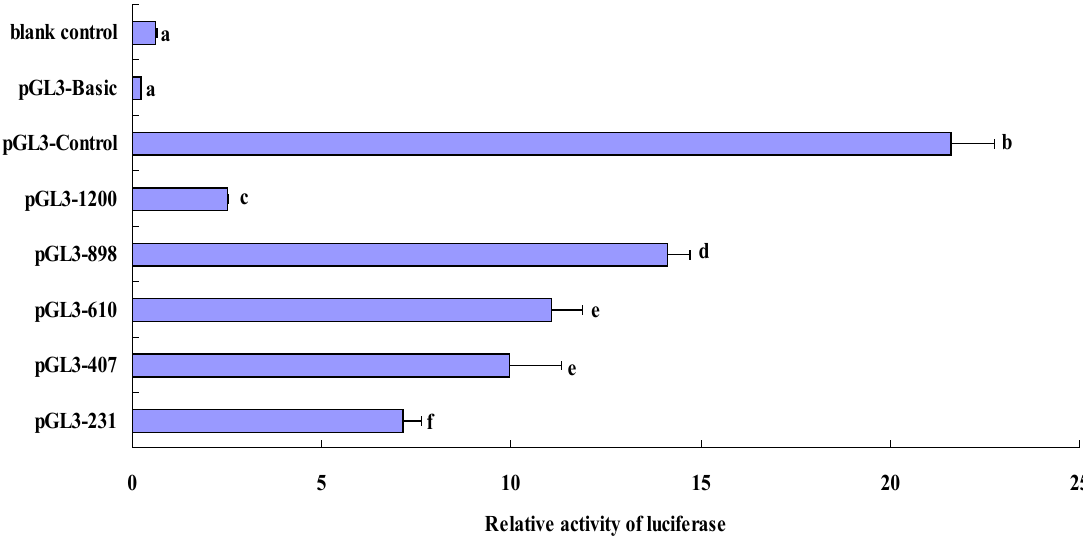
Figure 3. Luciferase activity analysis of recombinant plasmids in HEK293 cells. Different letters indicate significant differences ( p <